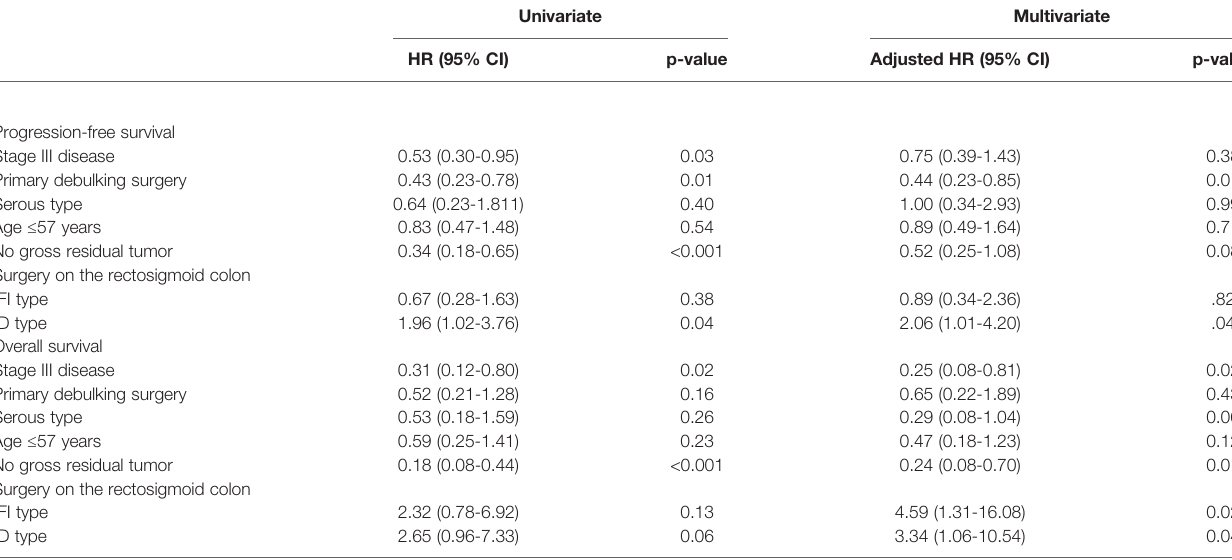
TABLE 4 | Factors affecting progression-free survival and overall survival.